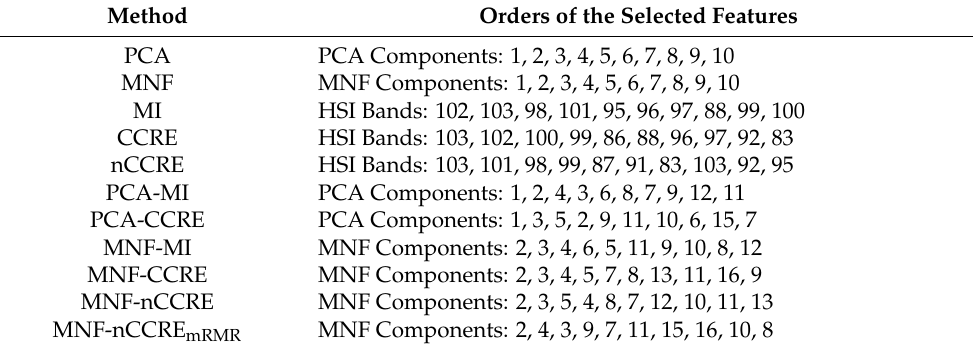
Table 5. The order of selected features for ROSIS PU dataset. Method Orders of the Selected